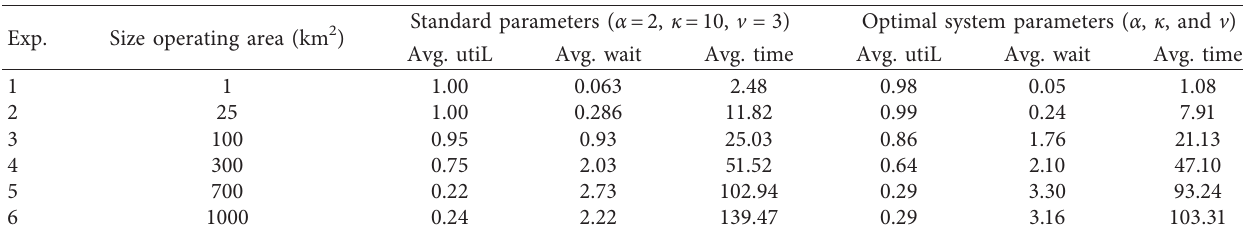
Table 2: Lean system performance results. System performance Comparing geometric-based optimal drone parameters to standard drone parameters